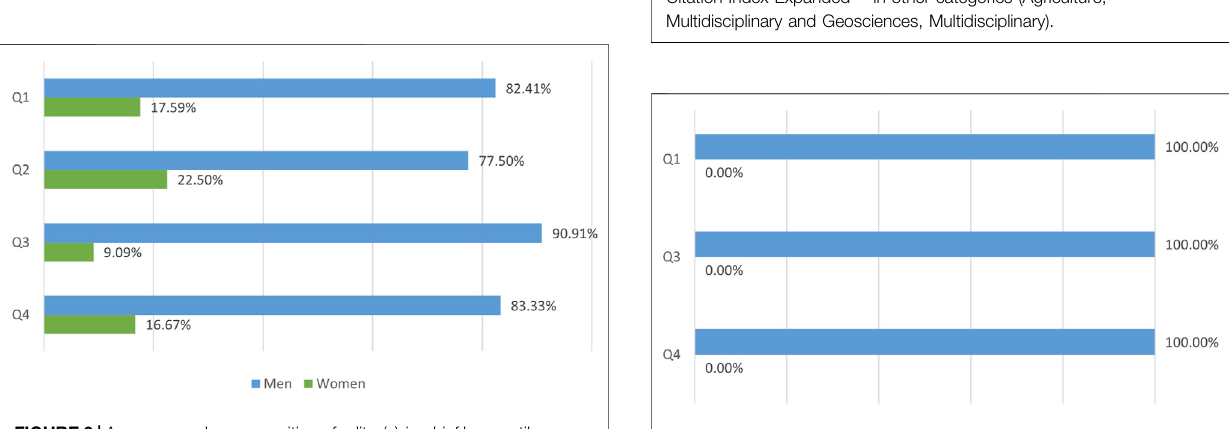
FIGURE 3 | Average gender composition of editor(s)-in-chief by quartile ranking of 47 journals classi fi ed within the category of “ Geology ” in 2020 and included in Science Citation Index Expanded ™ .